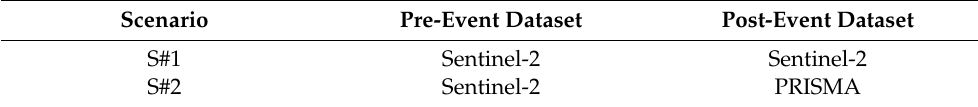
Table 3. Different scenarios for mapping of burned areas in two case-study areas.